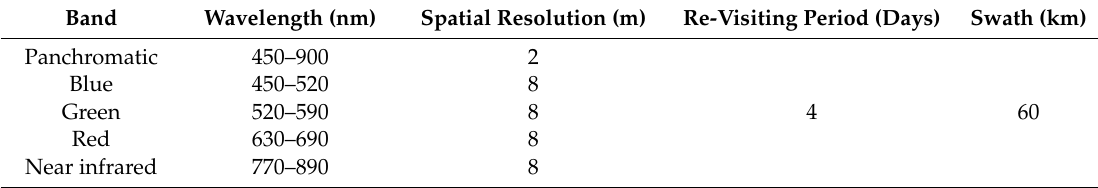
Table 2. Characteristics of panchromatic / multispectral sensors aboard on the GaoFen-1 satellite.